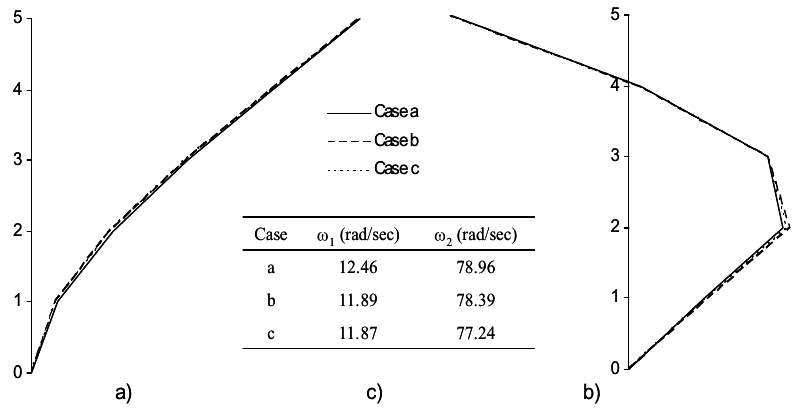
Fig. 6. Modes and frequencies of free vibration of the